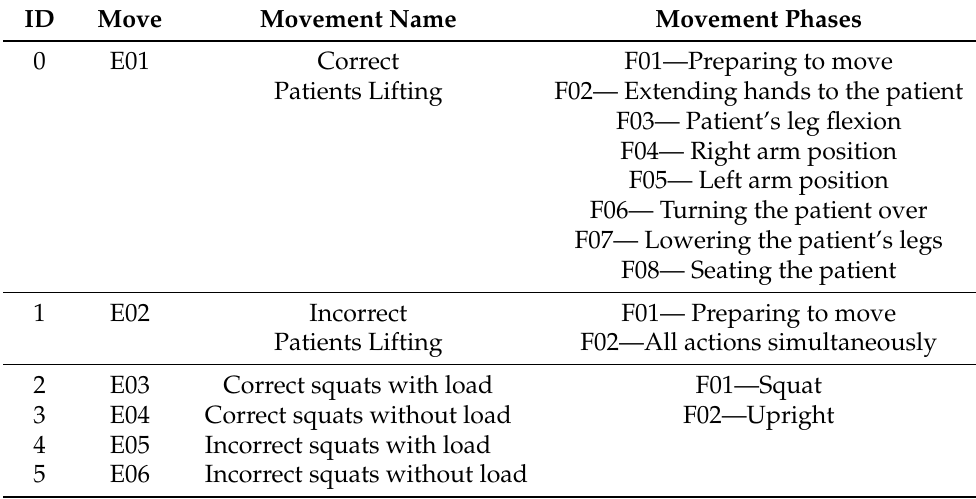
Table 4. Description of the patient lifting movement